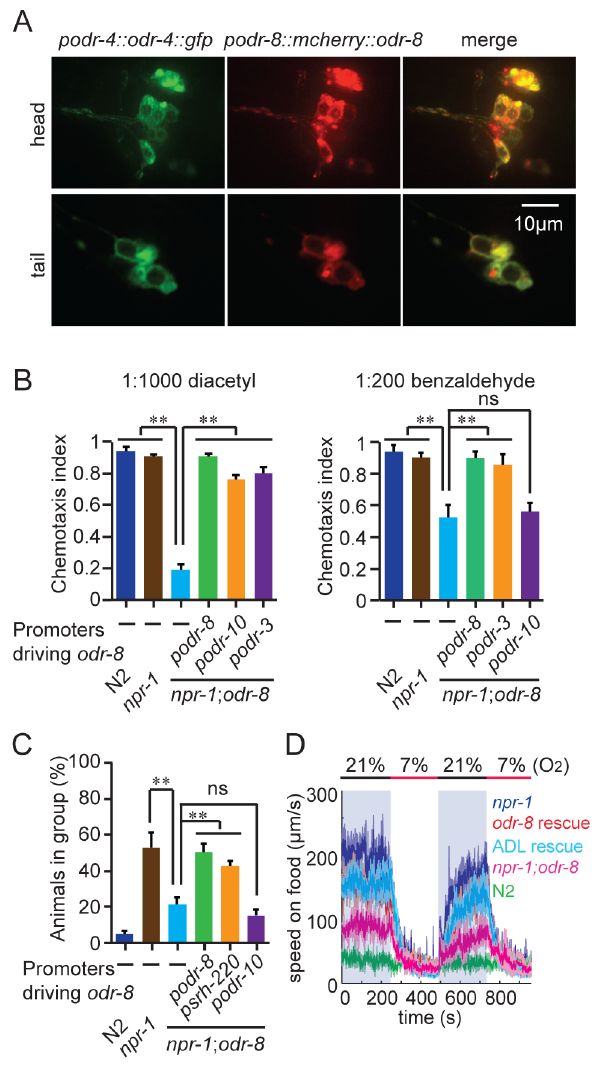
Figure 2. ODR-8 is co-expressed with ODR-4 in chemosensory neurons. (A) ODR-4 and ODR-8 are co-expressed in the same head and tail neurons. (B–D) Cell-specific rescue of odr-8(ky31) phenotypes. Like ODR-4, ODR-8 is required in AWA neurons for odortaxis to diacetyl (B), and in ADL neurons to sustain aggregation behavior (C) and high locomotory activity in 21% oxygen (D). The podr-10 promoter drives expression only in the AWA neurons; psrh-220 drives expression in ADL neurons; podr-3 drives expression in AWA, AWB, AWC, ASH and ADF. ** p , 0.01 (ANOVA, Bonferroni’s multiple comparisons test) compared to non-transgenic